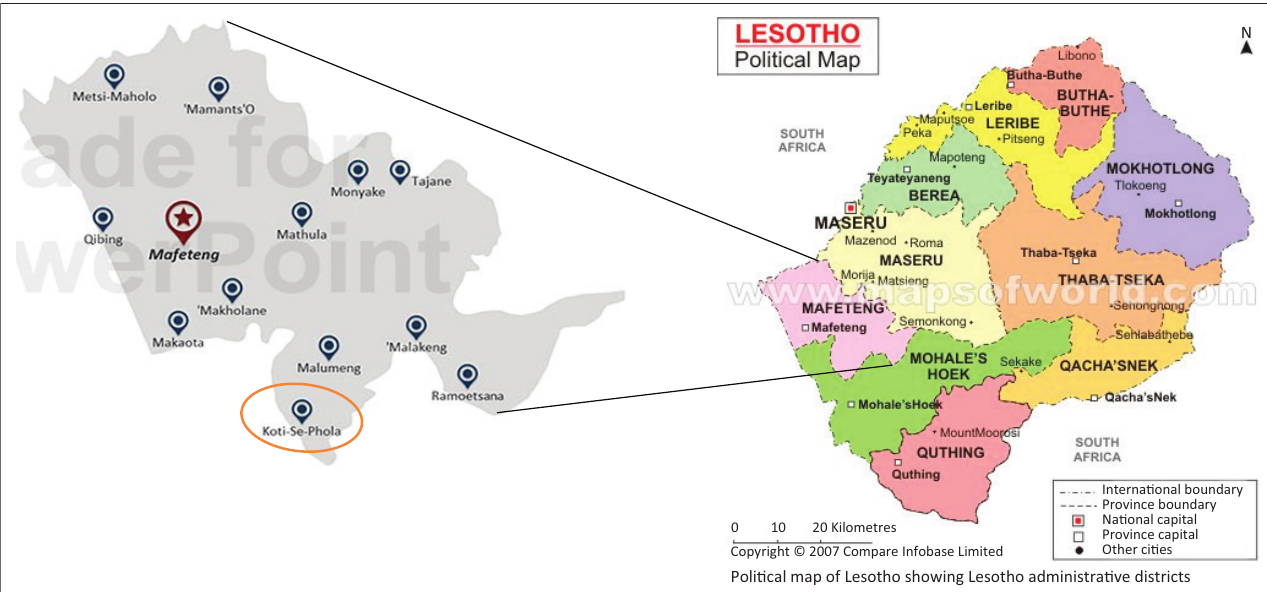
FIGURE 1: Mafeteng district community